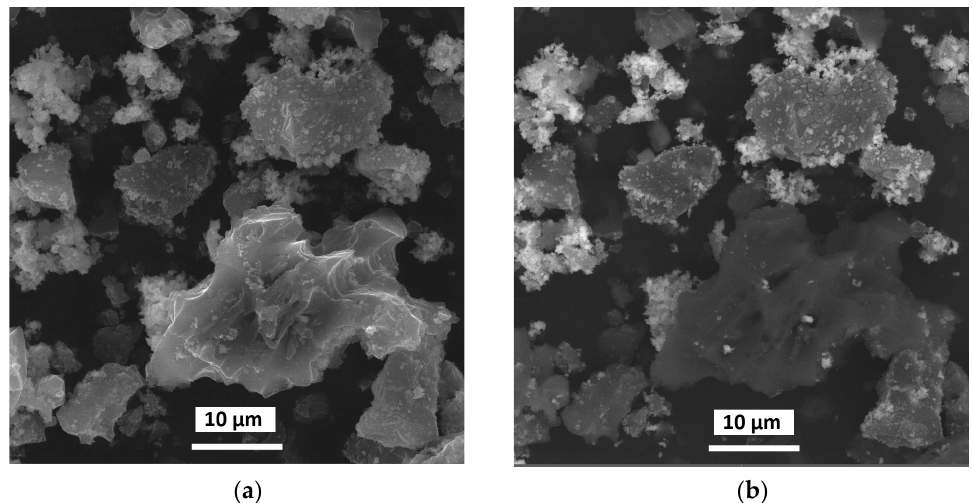
Figure 8. SEM images in secondary electrons mode ( a ) and backscattered electron mode ( b ) for Pd(OH) 2 /C-2.